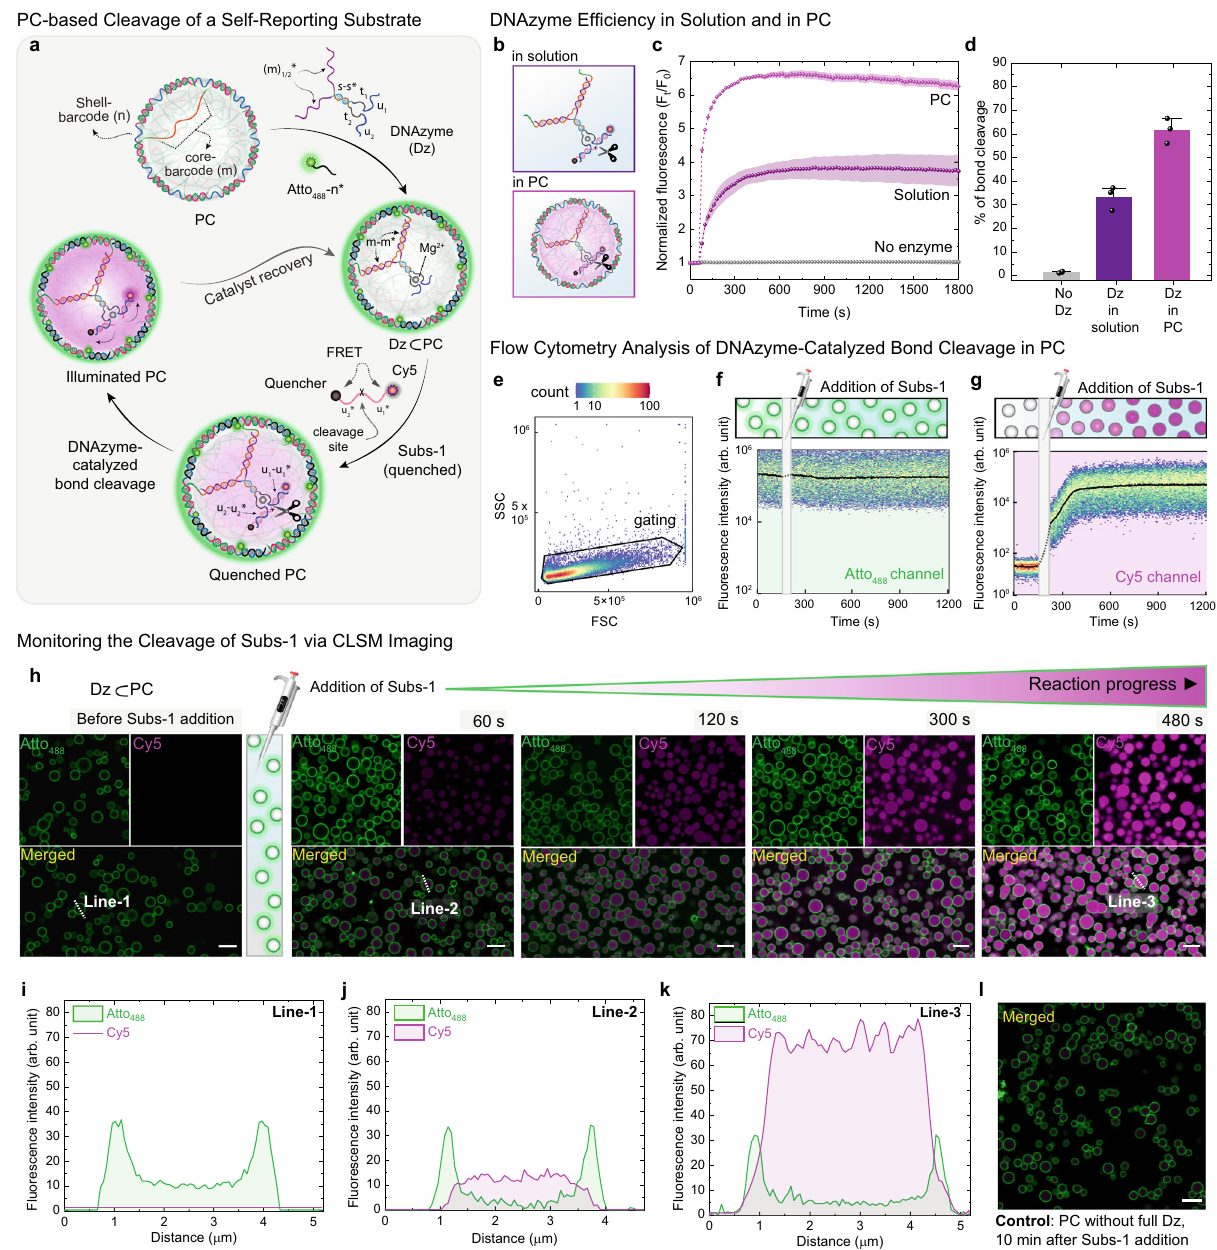
Fig. 2 Intra-protocellular catalytic cleavage of self-reporting substrate. a Schematic representation of a catalytic cycle for RNA linkage cleavage in Subs-1 in PC interior and fl uorescence enhancement upon uncaging the Cy5-appended product. b Schematic representation of two scenarios, where the DCBC is performed in (i) a buffered solution where the Dz is hybridized with a monomeric m-sequence, and (ii) in Dz ⊂ PCs. c Time-dependent spectro fl uorimetric investigation of DCBC in PC and solution. A control experiment in which the auto-cleavage of Subs-1 is also presented in the absence of Dz (gray trace). d The percentage of bond cleavage of Subs-1 in the three scenarios mentioned above. e PCs were identi fi ed in the forward scatter (FSC) versus side scatter (SSC) plot. f , g Intra-protocellular Atto 488 and Cy5 fl uorescence were monitored over time by fl ow cytometry. Black line shows the moving median. h The time-dependent CLSM images for DCBC induced Cy5-appended sequence uncaging in an Atto 488 -labeled PC system. The shell of all the PCs is labeled with Atto 488 -n* (green channel). At t = 0 (before the addition of Subs-1), all the PCs are visualized as green circles since the fl uorescent Atto 488 -n* is hybridized with the shell barcode domain ( n ) of p(T 20 -n) polymer. The DCBC in Dz ⊂ PCs is monitored over 8 min time period, and a gradual increase of Cy5 fl uorescence (magenta channel) at the PC core is observed. i – k Line segment analysis in both channels (green and magenta) of Line-1, Line-2, and Line-3 at t = 0, 1, and 8 min, respectively. l CLSM image of dormant PCs (without the Dz, only with Split-Dz-1) at t = 10 min after adding Subs-1. Data were the means ± standard deviation of duplicate reactions. Scale bars: 5 μ m. The error regions in panel c represent the standard deviation of two independent experiments. The error bar in d represents the standard deviation of three independent experiments ( N = 3). Condition: for spectroscopic measurements: [Dz ⊂ PCs], [Dz in solution] = 2 μ M, [Subs-1] = 5 μ M, for cytometry experiments: [Dz ⊂ PCs] = 0.5 μ M, [Subs-1] = 1.3 μ M and for the microscopic experiments: [Dz ⊂ PCs] = 7 μ M, [Subs-1] = 16.6 μ M, at 25 °C, TE buffer.